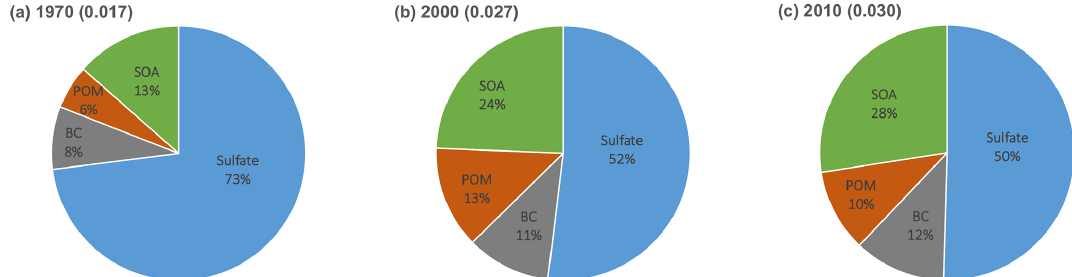
Figure 3. Contribution of sulfate, BC, POM, and SOA to anthropogenic aerosol optical depth (excluding dust, sea salt, and marine organic aerosols) in 1970, 2000, and 2010. Numbers in the panel title are the total anthropogenic aerosol optical depth ( (cid:49)τ a , ant = (cid:49)τ a , SO4 + (cid:49)τ a , BC + (cid:49)τ a , POM + (cid:49)τ a , SOA ). Results are calculated using the AMIP simulations. For example, the contribution from sulfate is calculated as (cid:49)τ a , SO4 /(cid:49)τ a , ant . See Sect. 3.1 for